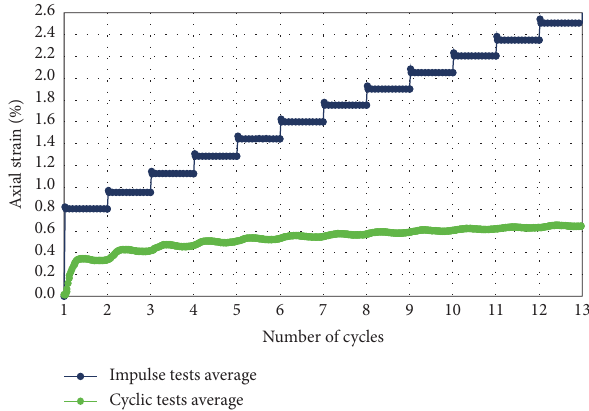
Figure 2: Comparison of impulse loading and uniform 1Hz cyclic